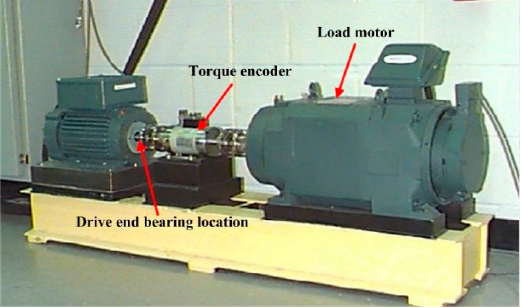
Figure 12. The bearing fault test bed from the bearing data center at the Laboratory of Case Western Reserve University